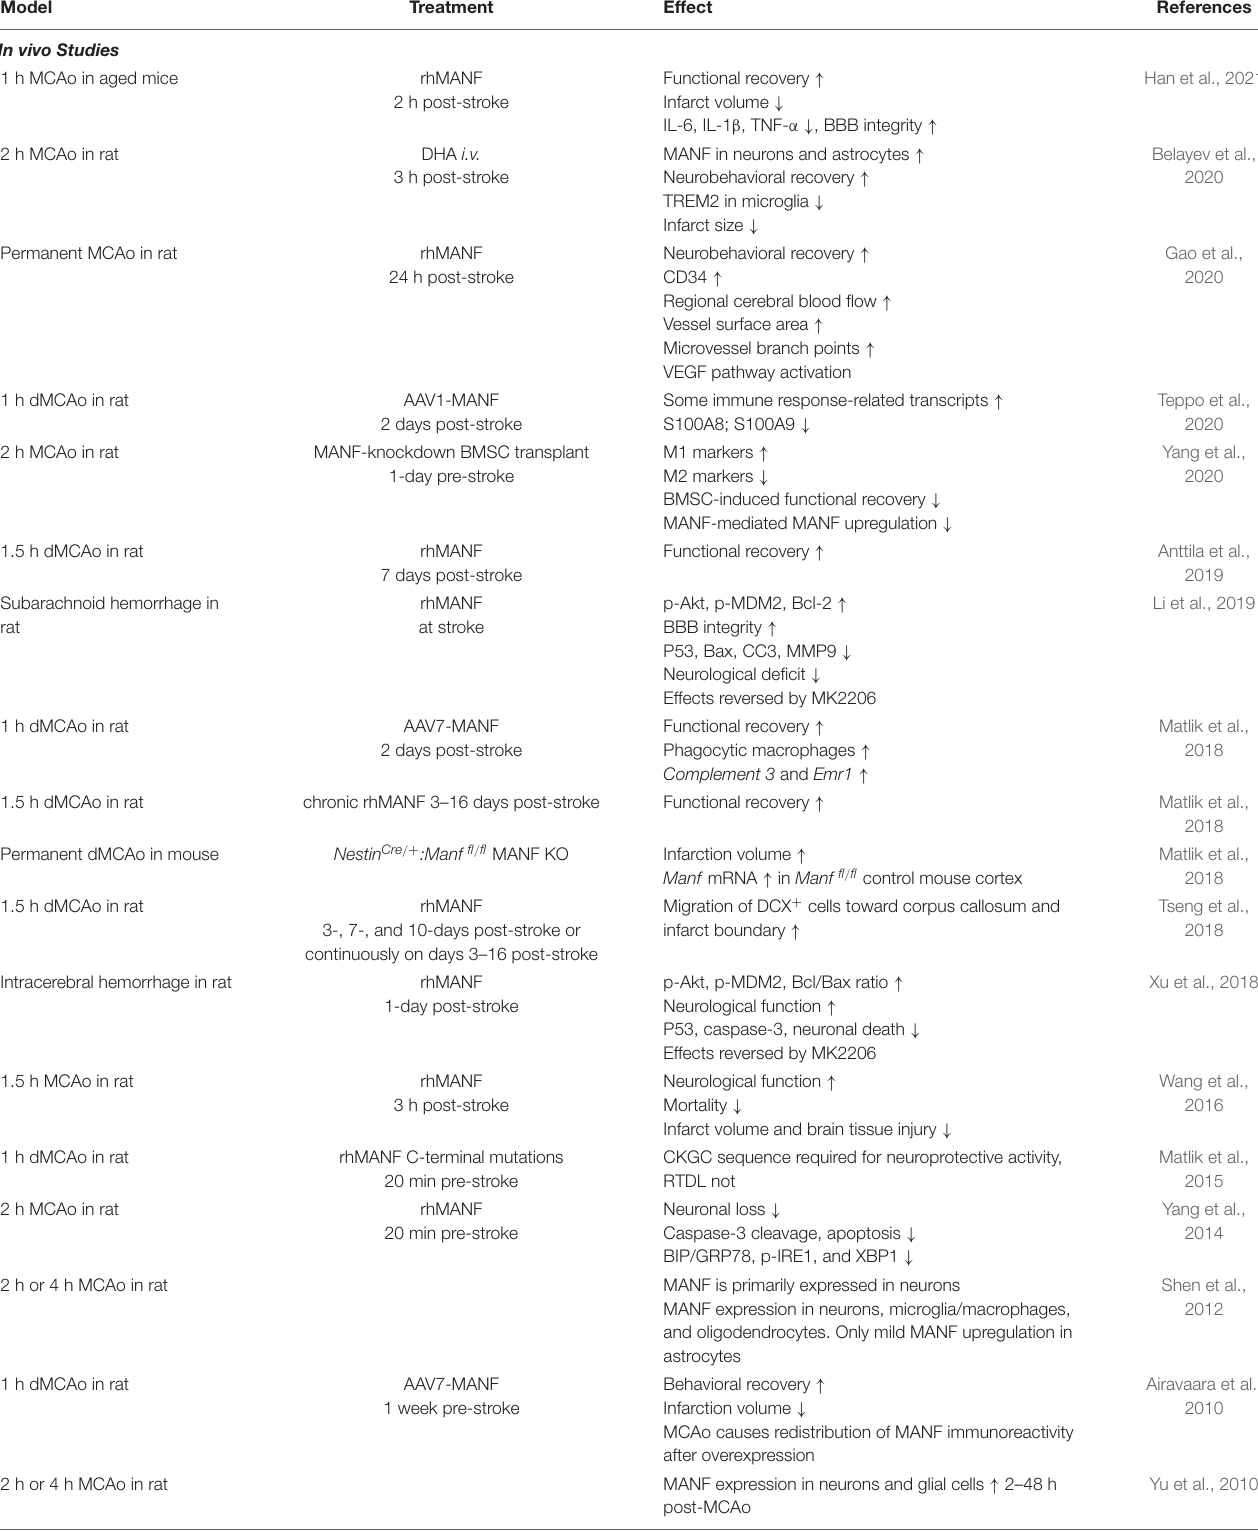
TABLE 1 | Effect of MANF in